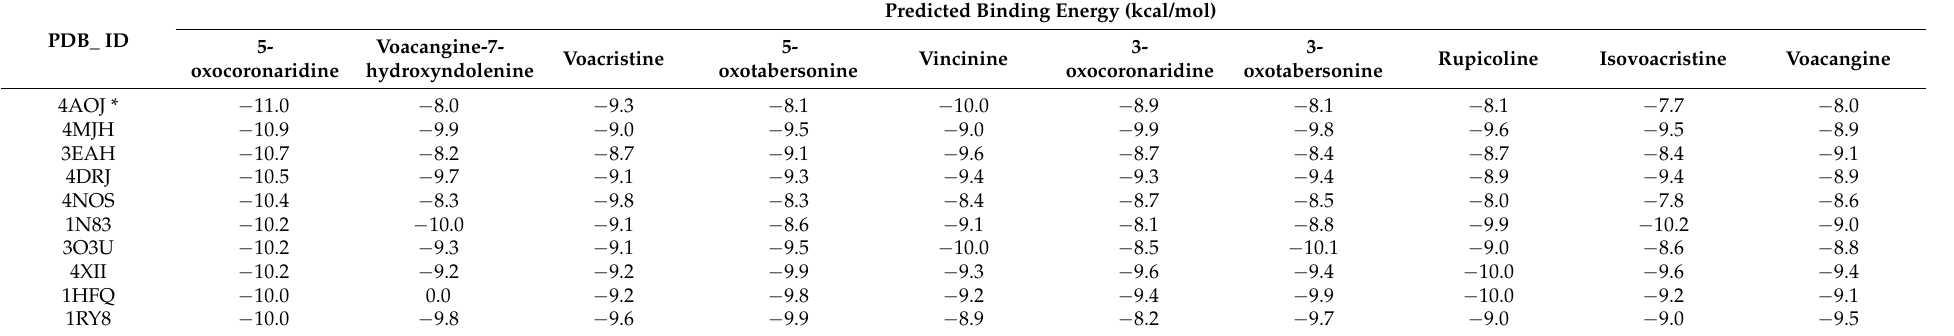
Table 2. Potential targets and binding affinities of Tabernaemontana cymosa alkaloids to human